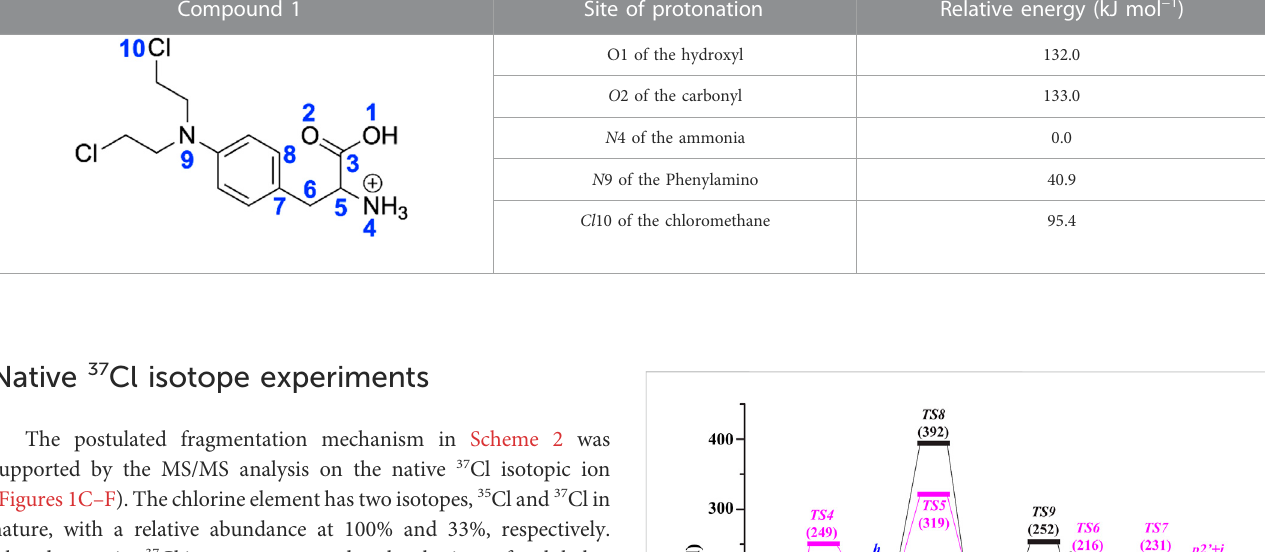
TABLE 1 Relative energies of [1 + H] + with different protonation sites calculated at B3LYP/6-31+G (d, p ) level. Compound 1